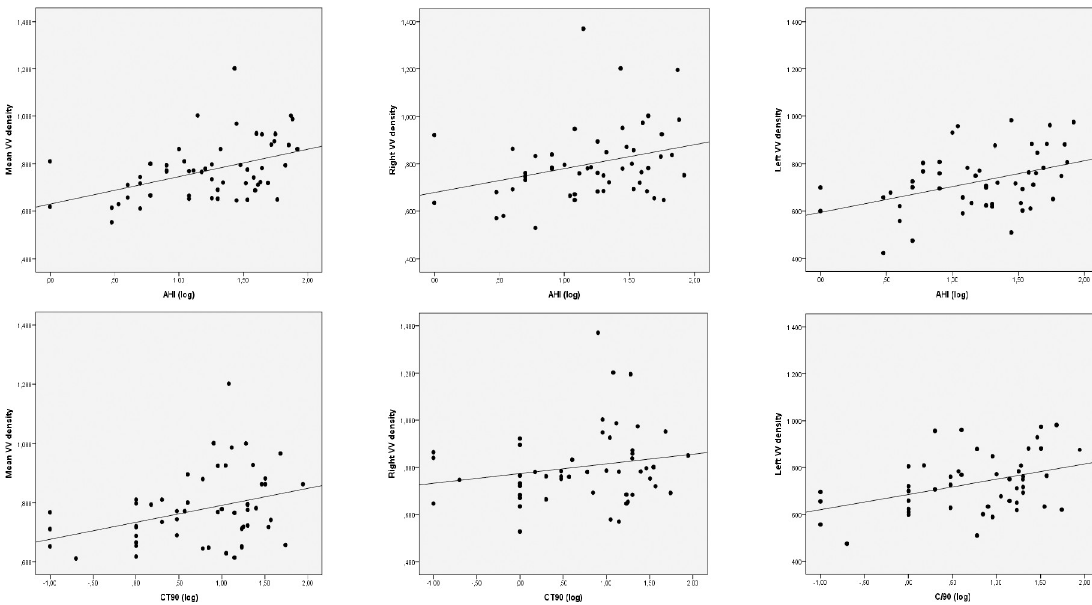
Fig 1. Correlations of the apnea-hypoapnea index (AHI) and the percentage of time spent with oxygen saturations below 90% (CT90) with vasa vasorum (VV) density (mean, right side and left side). ANOVA = 0.029). Subjects without SAHS showed serum VCAM-1 concentrations signifi- cantly lower than patients with moderate (p = 0.013) and severe (p = 0.016) SAHS. tial VV density and the AHI (log) (r = 0.445, p = 0.001) and CT90 (log) (r = 0.399, p = 0.005) ( Fig 1 ). The associations between carotid VV density and both nocturnal hypoxia parameters were maintained for the left side (AHI: r = 0.408, p = 0.003; CT90: r = 0.469, p = 0.001) but par- tially disappeared for the right one (AHI: r = 0,302, p = 0.029; CT90: r = 0,222, p = 0.142, plasma glucose (r = 0.321, p = 0.017), triglycerides (log) (r = 0.304, p = 0.030), neck (p = 0.003, p = 0.388) and waist circumferences (p = 0.028, r = 0.296), as well as with the serum concentra-